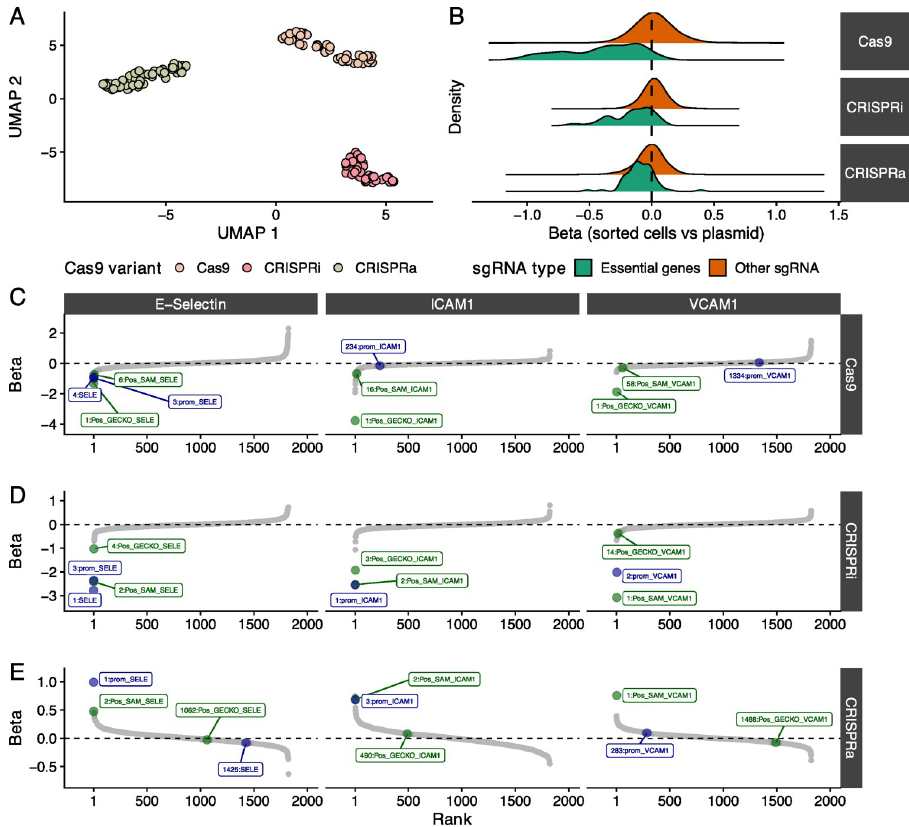
Fig 2. Quality-controls of the pooled CRISPR screens for vascular endothelial cell phenotypes. ( A ) Two- dimensional uniform manifold approximation and projection (UMAP) representation of 148 fluorescence-activated cell sorting (FACS) samples based on the normalized read counts of the top 10% most variable sgRNAs across all samples. ( B ) Density distributions of effect sizes (Beta, x -axis) across all Cas9 variants for essential genes and the rest of the sgRNA library. Positive betas indicate that sgRNA are enriched in the cell fractions when compared to the input library, while negative betas indicate a depletion of sgRNA across all samples. We observed a depletion of sgRNA targeting essential genes with all three Cas9 variants. ( C-E ) Rank of all control sgRNAs and targeted CAD variants in the ( C ) Cas9, ( D ) CRISPRi and ( E ) CRISPRa screens for three adhesion proteins: E-selectin (left), VCAM1 (middle) and ICAM1 (right). For each panel, the y -axis corresponds to the effect sizes (Beta, comparing top vs bottom FACS 10% fractions). For the Cas9 and CRISPRi experiments, we found an enrichment of sgRNAs targeting the coding and promoter sequences of genes encoding adhesion proteins in the bottom 10% cell fractions (negative Betas). In contrast, sgRNAs targeting the promoter of these genes were enriched in the top 10% cell fractions in the CRISPRa experiments. In green and blue, we highlight sgRNAs targeting coding exons and promoters, respectively. The number in front of the name of each control sgRNA indicates its rank in the corresponding